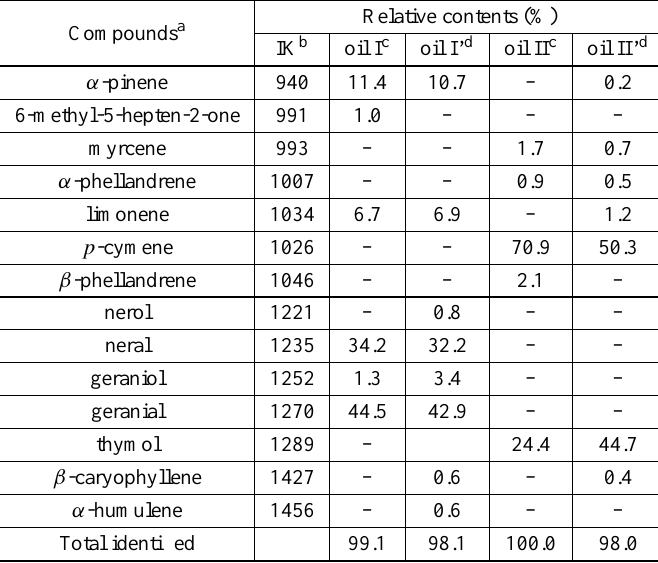
Volatile components identified in the essential oils from aerial parts of P. apodocephala (oils I and I’) and P. oligocephala (oils II and II’). Relative contents (%) Compounds a